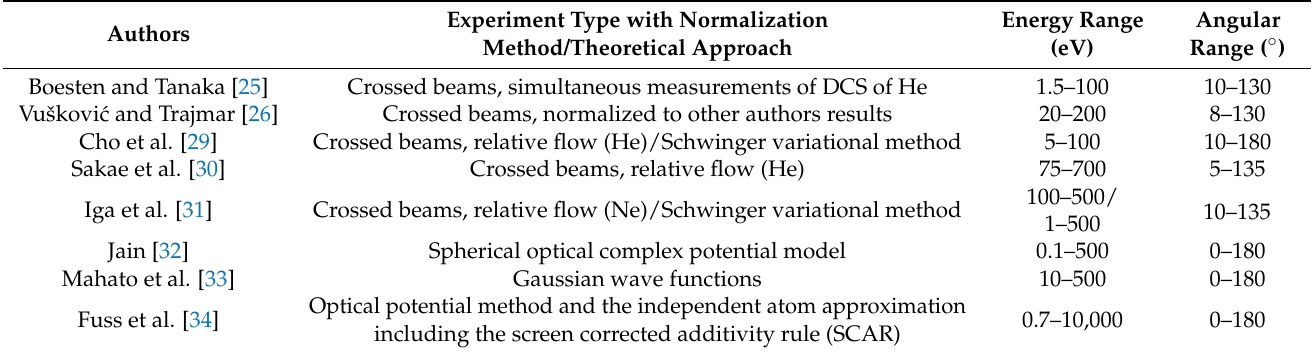
Table 1. List of experimental and theoretical work on differential cross-section (DCS) for elastic scattering of electrons from methane molecule, covering energy range from 50 to 300